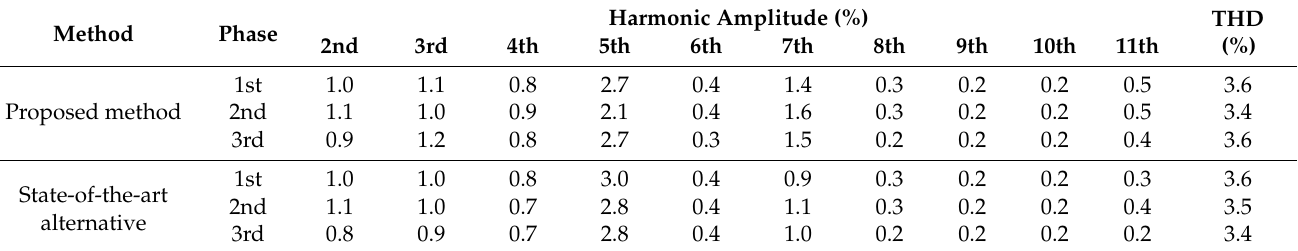
Table 3. Current harmonic content.